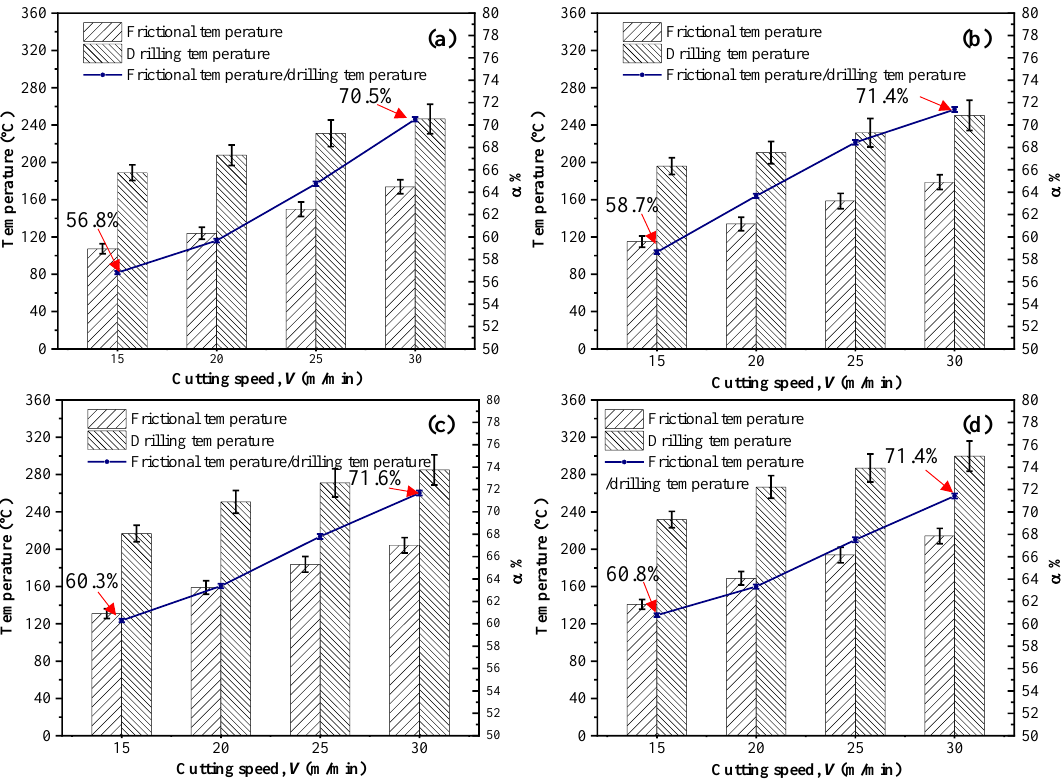
Figure 9. Temperature variations during the drilling and frictional tests under different cutting parameters: ( a ) f = 0.01 mm/rev, ( b ) f = 0.02 mm/rev, ( c ) f = 0.03 mm/rev and ( d ) f = 0.04 mm/rev.